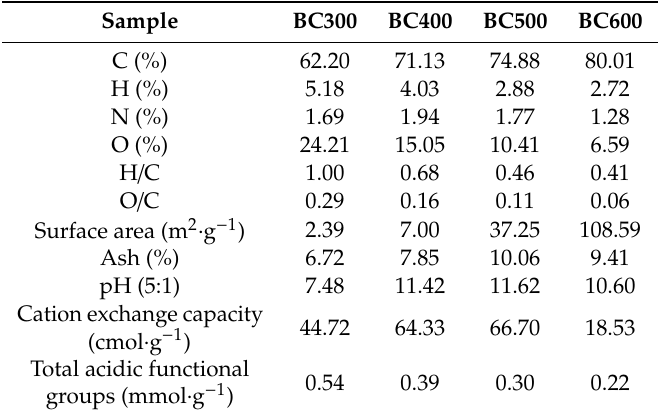
Table 1. The main characteristics of biochars produced at di ff erent